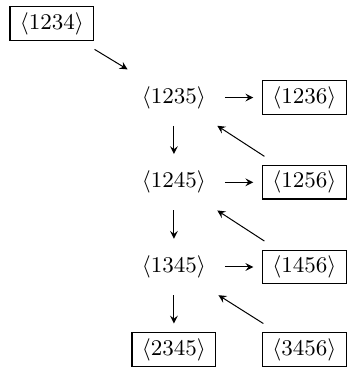
Figure 2. The quiver diagram for the initial cluster for the algebra associated to Conf 6 ( P 3